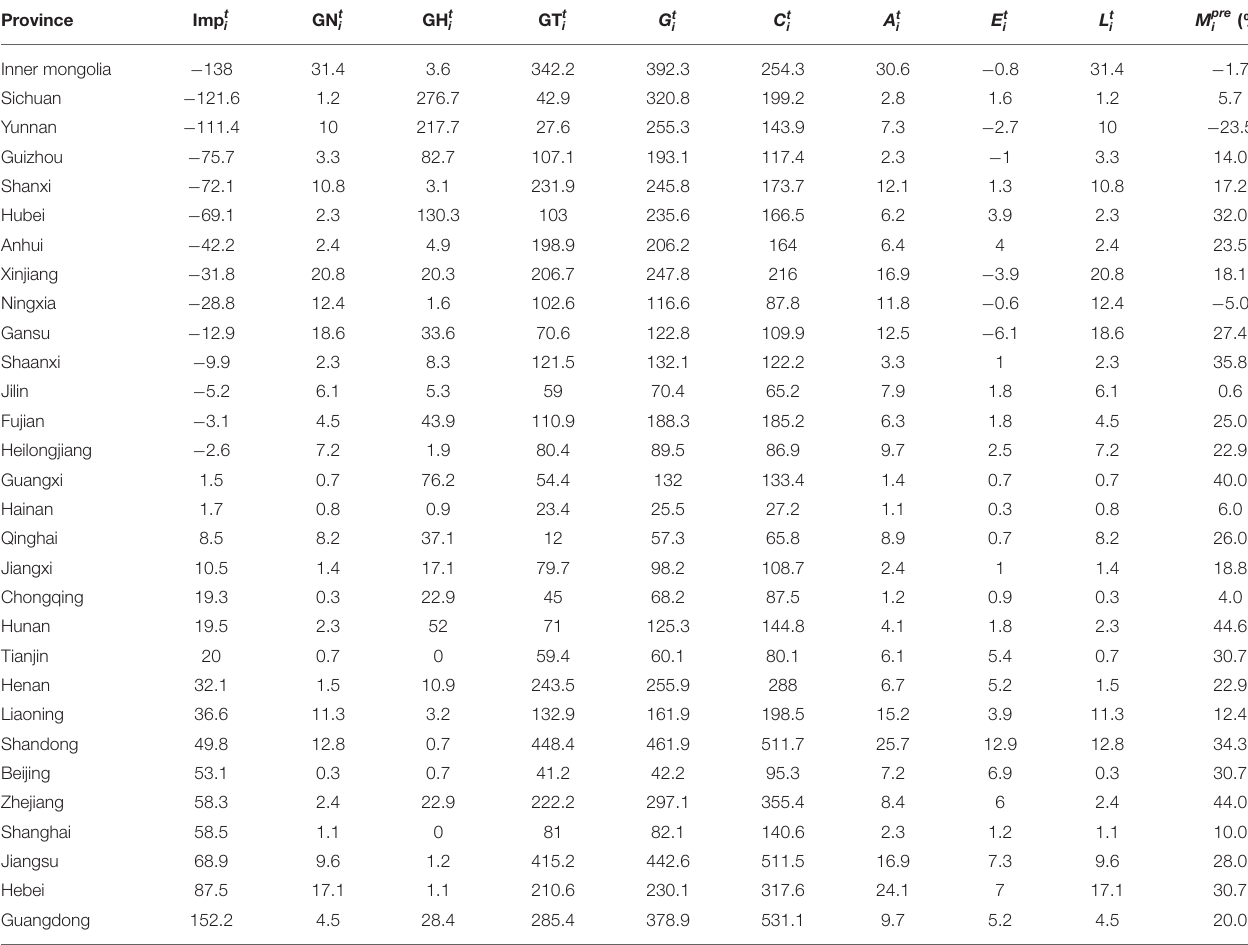
TABLE 2 | Structural data of the provincial electricity balance and accommodation,